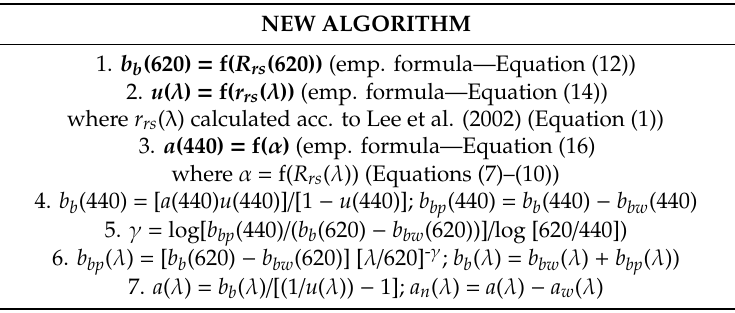
Table 1. An example of the new semi-analytical